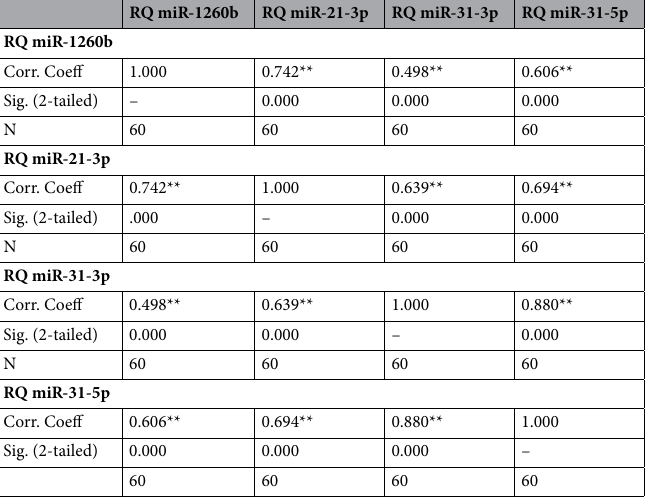
Table 2. Correlations between microRNAs associated with tumor grade (miR-1260b, miR-21-3p, miR-31-3p and miR-31-5p). *Correlation is significant at the 0.05 level (2-tailed). **Correlation is significant at the 0.01 level